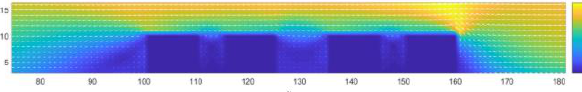
Fig. 3. Vertical field (colour map) of velocity magnitude U [m/s] at the middle section of courtyards 2 and 3 (the undisturbed velocity U 0 is 2.3 m/s from the right), with the velocity vectors in white, for the configuration